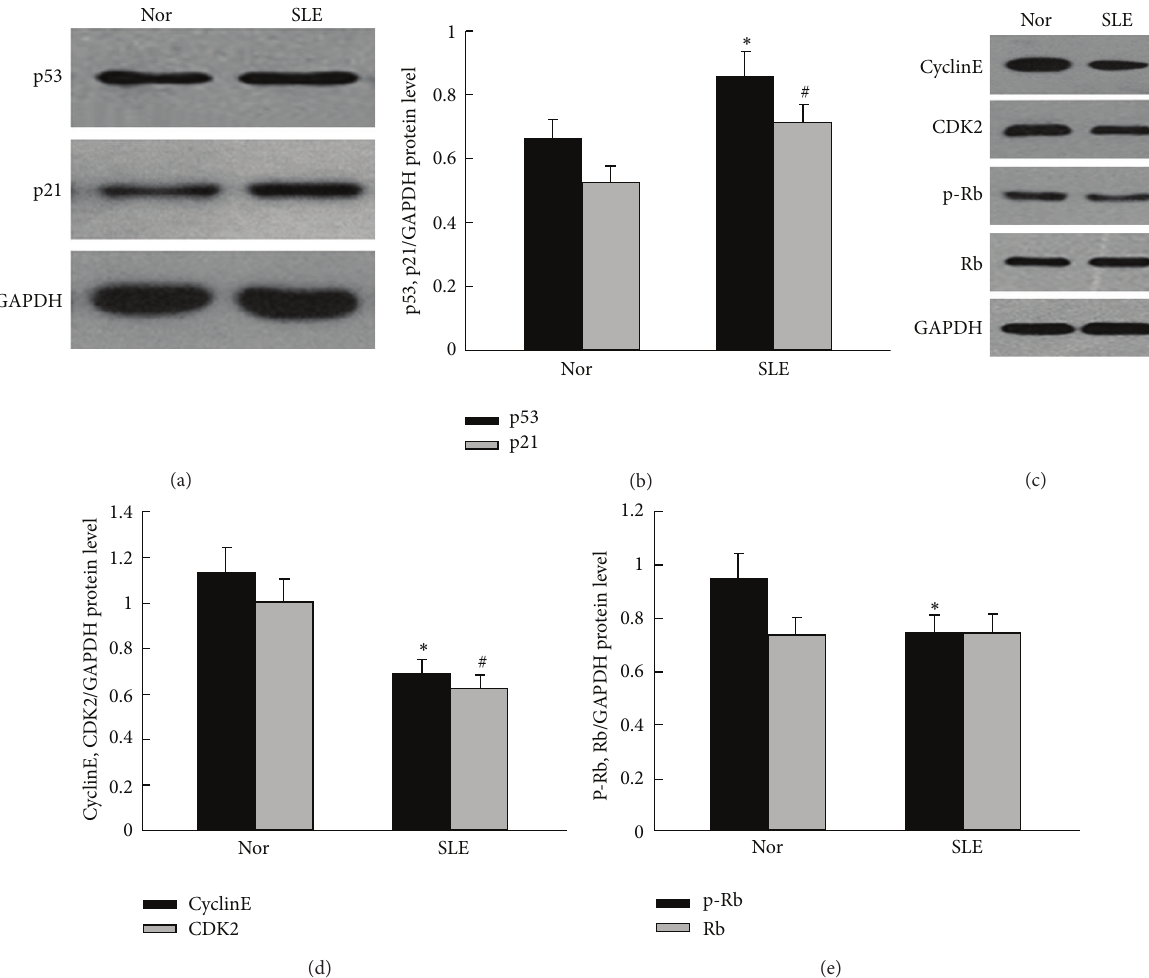
Figure 2: The expression of p53/p21 and cell cycle-related molecules in BM-MSCs from SLE patients. Western blot was used to analyze p53/p21 and their relative proteins expressions. (a) The expression of p53 and p21 was significantly increased in BM-MSCs from SLE patients. (b) Quantification of p53 and p21 protein levels: the relative levels of protein expressions were normalized to GAPDH expression. Values are means ± SD of three experiments ( ∗ 𝑃 < 0.05 ; # 𝑃 < 0.05 ). (c) Western blot analysis and the expressions of Cyclin E, CDK2, and p-Rb in BM- MSCs from SLE patients were decreased. (d) Quantification of Cyclin E and CDK2 protein levels: the relative levels of protein expressions were normalized to GAPDH expression. Values are means ± SD of three experiments ( ∗ 𝑃 < 0.05 ; # 𝑃 < 0.05 ). (e) Quantification of p-Rb and Rb protein levels: the relative levels of protein expressions were normalized to GAPDH expression. Values are means ± SD of three experiments ( ∗ 𝑃 < 0.05 ). GAPDH was used as the internal control. Total p53 and p21 were significantly increased in BM-MSCs from SLE patients, while the expressions of Cyclin E, CDK2, and p-Rb were significantly decreased in BM-MSCs of SLE patients when compared with those in normal